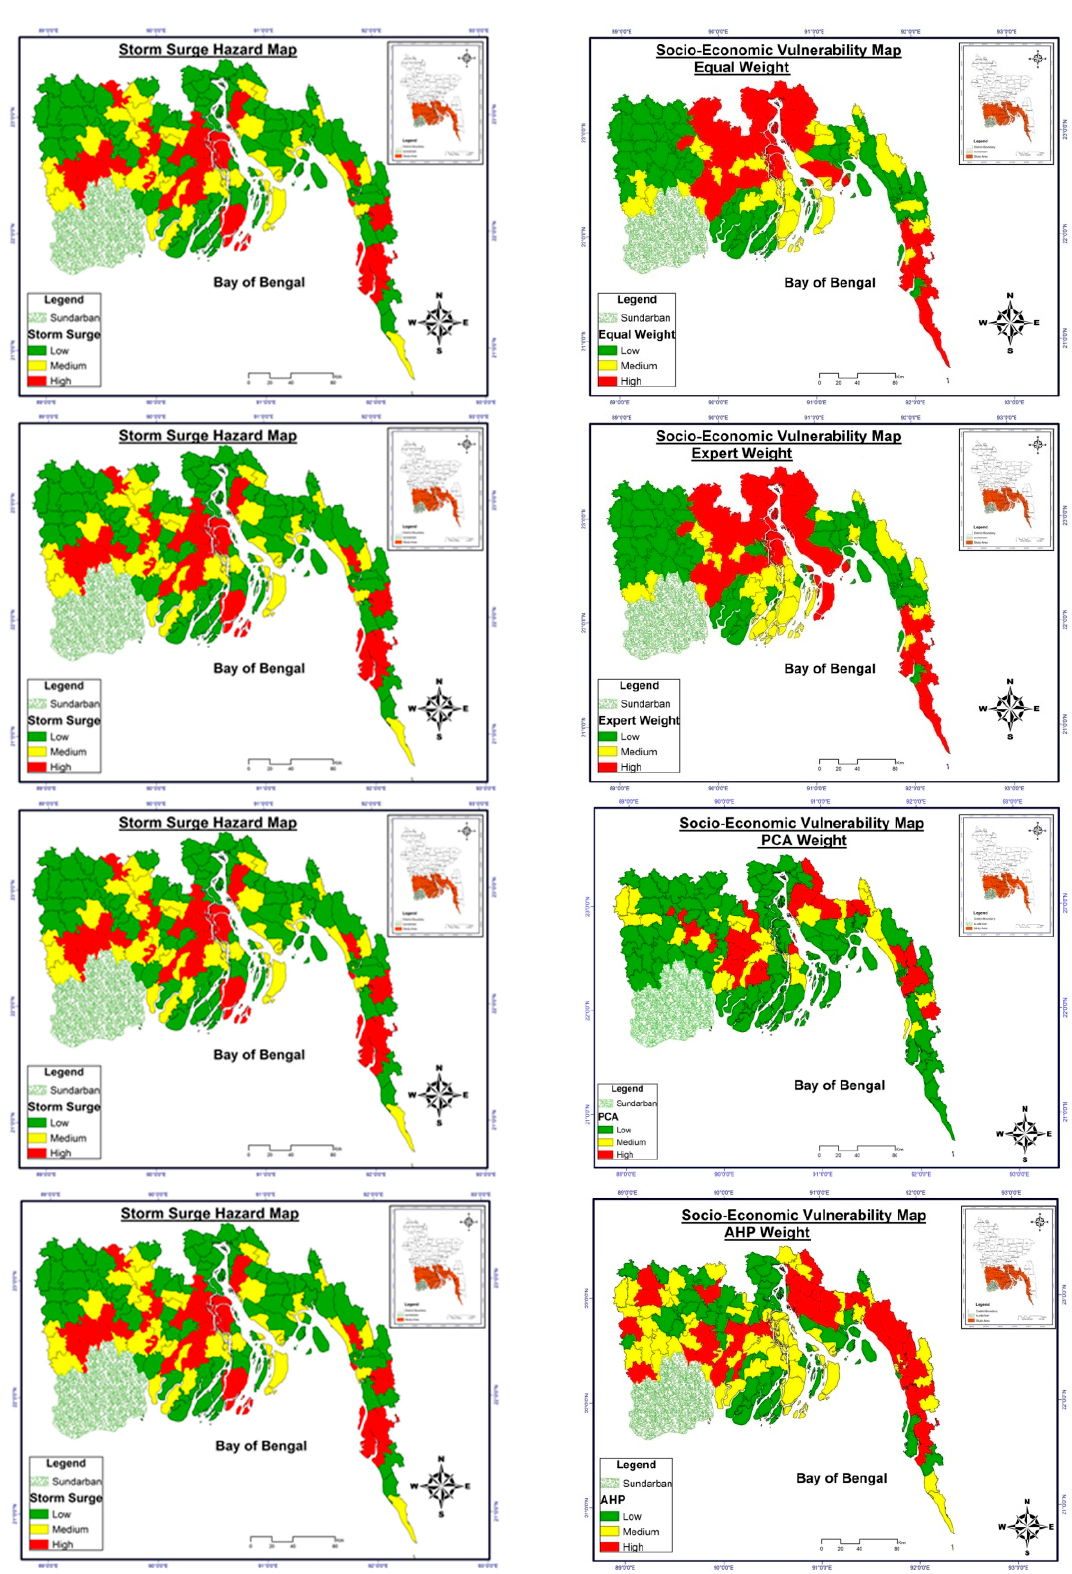
Figure 4. Comparison of storm surge hazard map (left) and socio ‐ economic vulnerability maps (right)